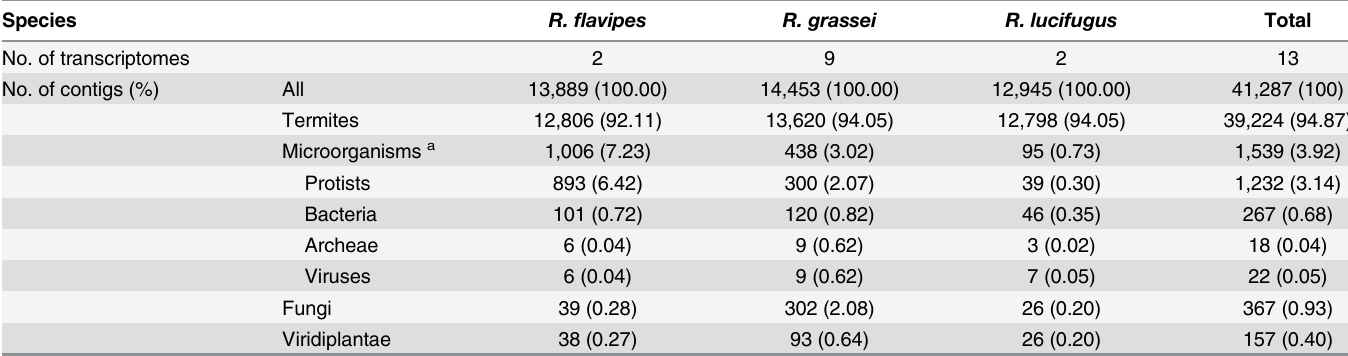
Table 3. Taxonomic assignation of contigs obtained in the three termite species. Species R. fl